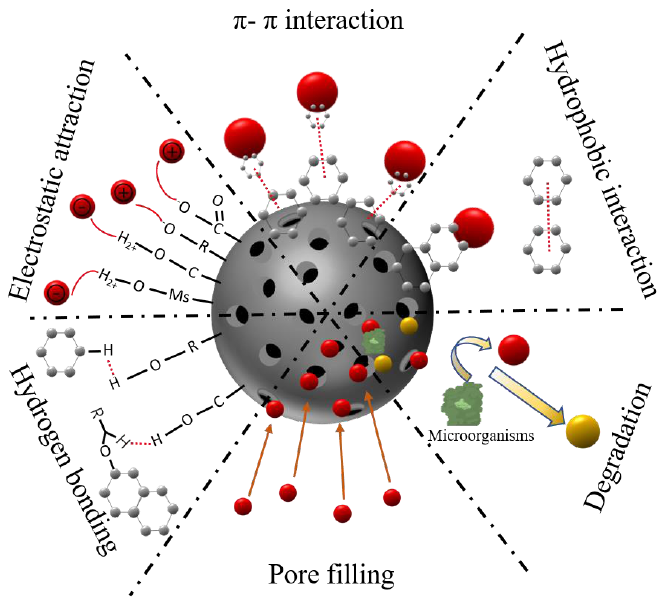
Figure 2. Possible mechanisms of biochar for emerging pollutants adsorption.